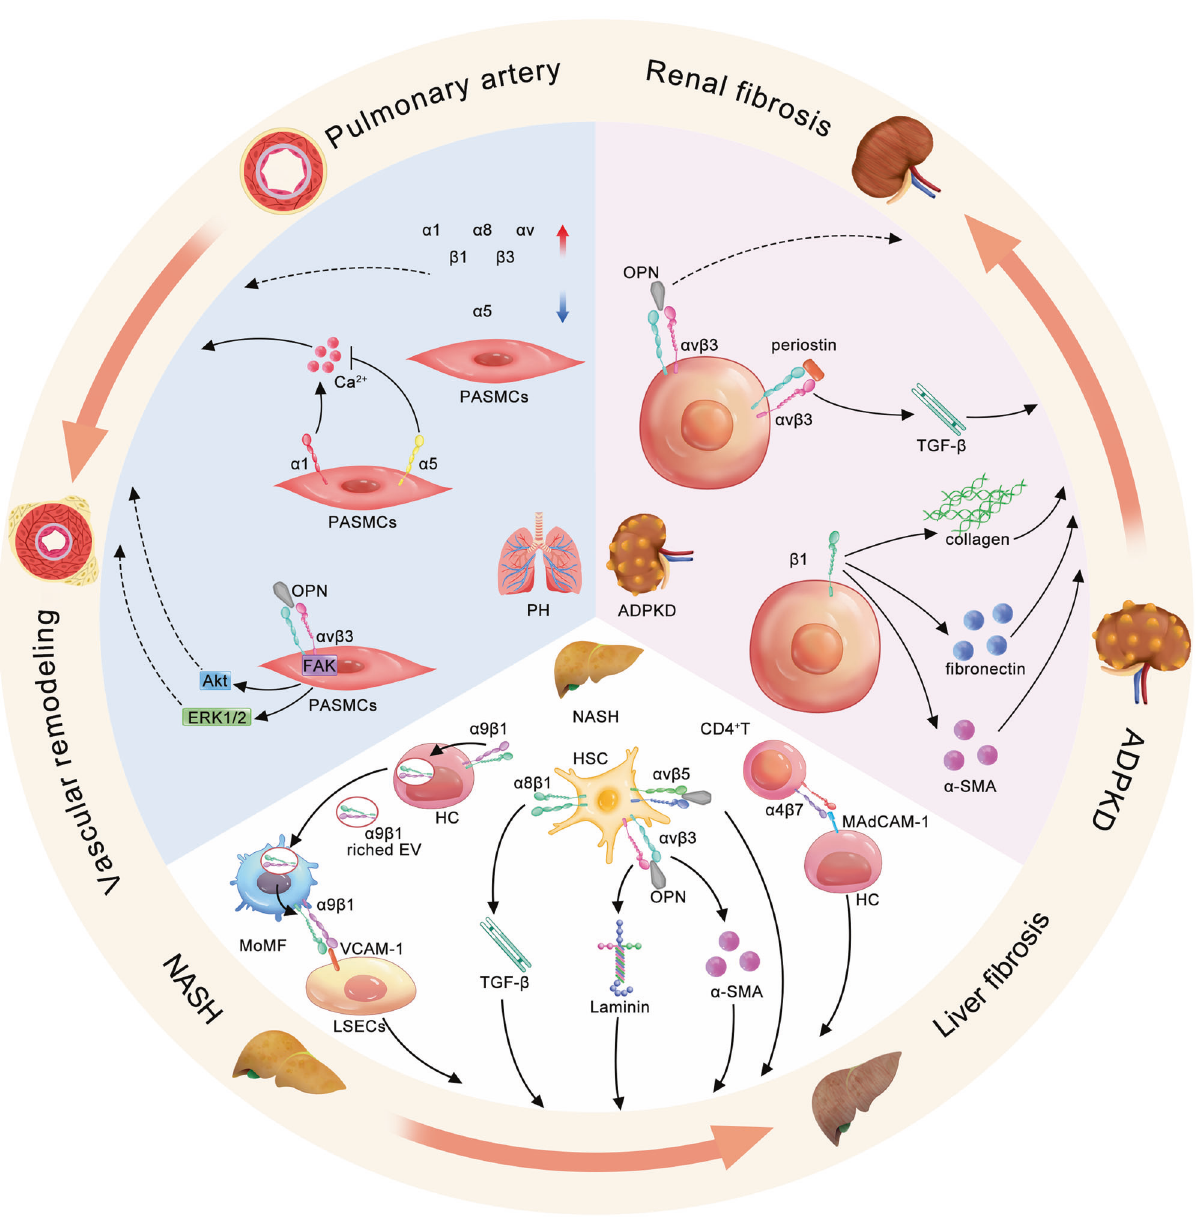
Fig. 6 Roles of integrins in fi brosis processes in NASH, PH, and ADPKD. The lower part of the circle shows the role of integrins in liver fi brosis in NASH. In hepatic cells (HCs), activated integrin α 9 β 1 is endocytosed by hepatocytes and secreted in the form of extracellular vesicles (EVs), which are further captured by MoMFs. Captured integrin α 9 β 1 mediates MoMF adhesion to liver sinusoidal endothelial cells (LSECs) by binding to VCAM-1, which accelerates liver fi brosis. In HSCs, integrin α 8 β 1 promotes liver fi brosis by activating TGF- β . The binding of integrin α v β 3 with OPN could promote laminin and α -SMA expression, which causes ECM accumulation and fi brosis progression. Integrin α v β 5 also binds with OPN and enhances liver fi brosis, but the underlying mechanism still needs to be clari fi ed. In CD4 + T cells, the adhesion between integrin α 4 β 7 and HC expressing MAdCAM-1 recruits CD4 + T cells to the liver, which induces liver in fl ammation and fi brosis. The left part of the circle shows the role of integrins in intimal fi brosis in PH. In the progression of PH, integrin α 1, α 8, α v, β 1, and β 3 are upregulated, and α 5 is downregulated in PASMCs. Integrin α 1 increases and α 5 decreases the concentration of Ca2 + , promoting intimal fi brosis. The binding between integrin α v β 3 and OPN activates FAK signal transduction, which might be involved in the processes of vascular remodeling. The right part of the circle shows the role of integrins in renal fi brosis in ADPKD. Integrin α v β 3 expressed in renal tubular epithelial cells binds with periostin, activating TGF- β and promoting renal fi brosis. Binding between integrin α v β 3 and OPN is also involved in the renal fi brosis process, but the underlying mechanism is unclear. Renal tubular epithelial cells expressing integrin β 1 enhance the expression of collagen, fi bronectin, and α -SMA, which promote renal fi α 11 and RGD-recognizing integrins (such as α IIb β 3 and α 5 β 1) are elucidated. It may be a promising direction for the treatment of NASH-derived liver fi brosis. also important regulators of liver fi brosis. 339 Integrin inhibitors such as IDL-2965 and PLN-74809 have been investigated in clinical trials PH . PH is a disorder of the pulmonary vasculature de fi ned by to evaluate their therapeutic effect on liver fi brosis. 339 However, increased pulmonary vascular resistance ≥ 3 Wood units. 340 It is none of their roles in fi brosis induced by NASH have been